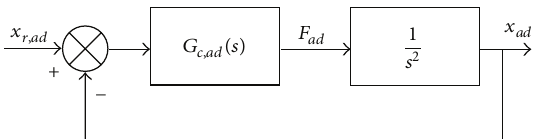
Figure 3: Block scheme of the dimensionless closed-loop system.